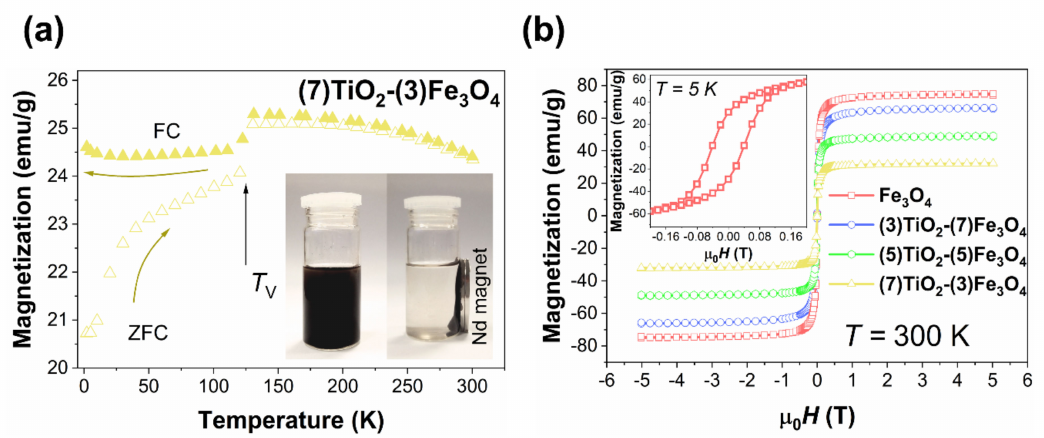
Figure 8. Magnetic properties of TiO 2 -Fe 3 O 4 composites: ( a ) Magnetization of selected composite vs. temperature. The inset shows magnetic separation of TiO 2 -Fe 3 O 4 composites suspended in water. ( b ) Magnetization vs. external magnetic field. The inset shows the magnetic loop for pristine Fe 3 O 4 at 5